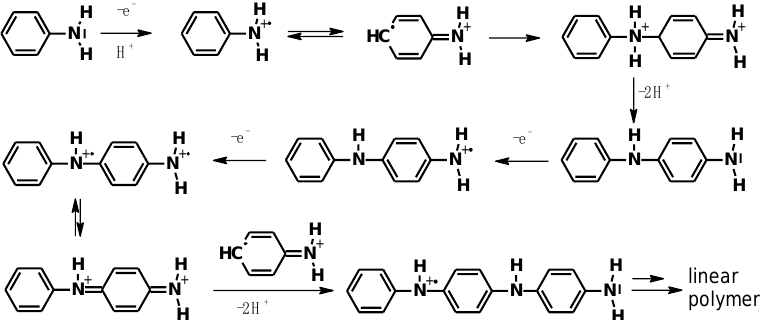
Figure 4. Reaction mechanism for radical cation coupling of aniline, leading to the forms of a linear polymer.